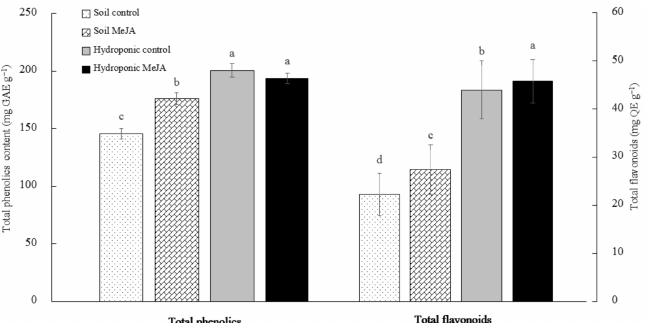
Figure 4. Total phenolic and flavonoid contents of pak choi grown in soil or hydroponics with or without the treatment of MeJA. Different letters on the bars indicate a significant difference ( p < 0.05) between the treatments. The vertical bars represent the standard error of the mean ( n =